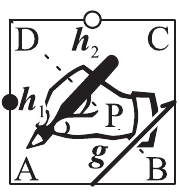
Figure 3. A fundamental domain of